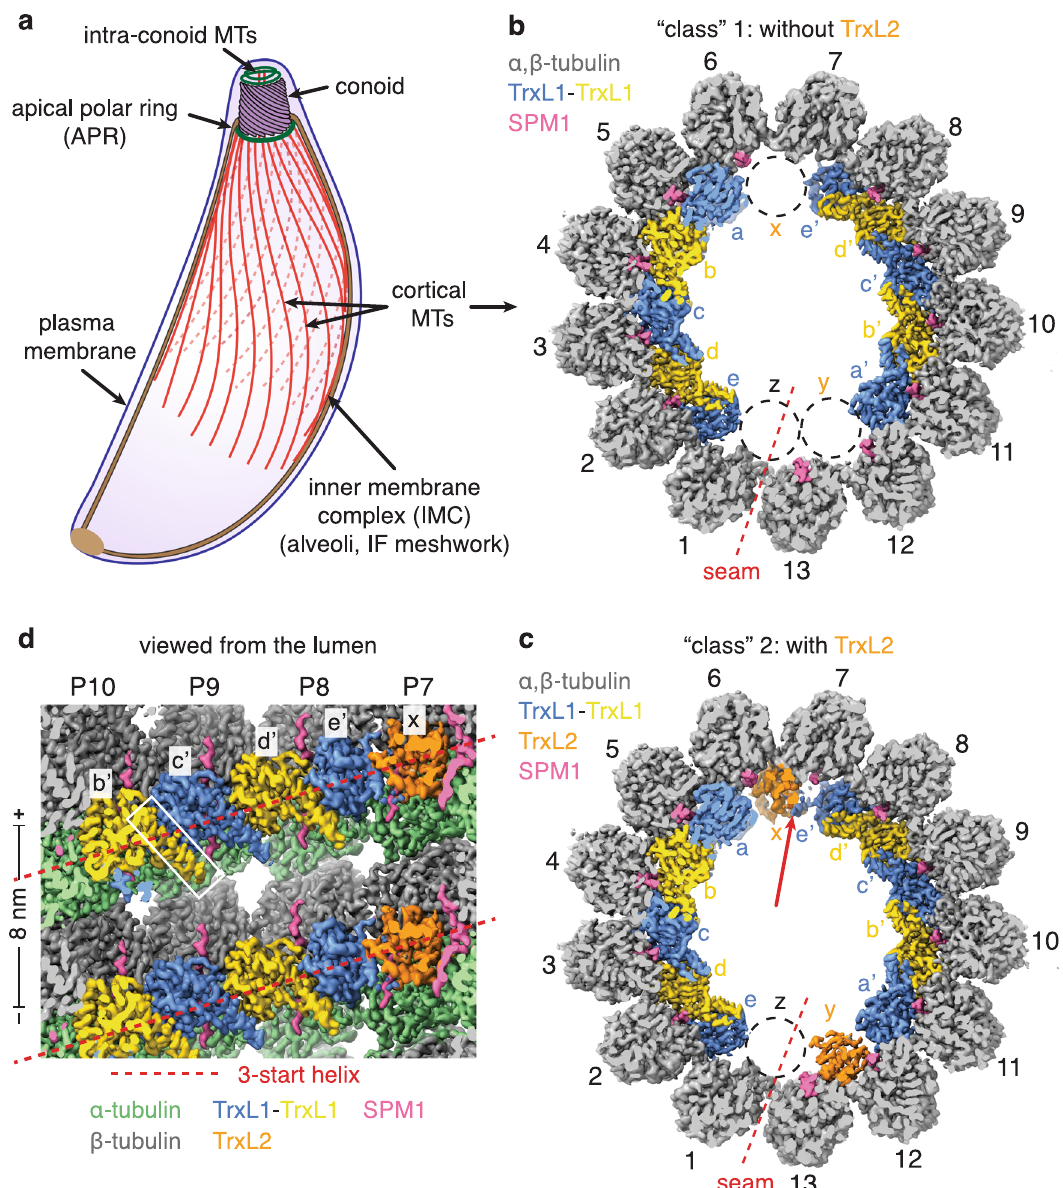
Fig. 1 Overview of the cryo-EM structures of cortical MT from T. gondii . a Cartoon diagram of T. gondii showing plasma membrane, inner membrane complex (IMC) (including the alveoli and an intermediate fi lament (IF)-like protein meshwork), the apical complex (a conoid and two intra-conoid MTs), the apical polar ring (APR) and 22 cortical MTs. b – c Cross section view of the cryo-EM structure of T. gondii cortical MT with ( b ) and without ( c ) TrxL2 at sites x and y. The structures show an asymmetric arrangement of the microtubule inner proteins (MIPs) including TrxL1 (gold or blue), TrxL2 (orange), and SPM1 (pink). An unoccupied site at the MT seam is labeled as z. Composite DeepEMhancer-sharpened maps (see “ Methods ” ) are used for visualization. The quotation marks on “ class ” 1 and “ class ” 2 indicate that the two composite maps only differ in sub-regions containing sites x and y. d The same as ( c ), but showing the luminal surface of the tubulin and MIPs. The N-terminal helix of TrxL1 (marked by white rectangle) inserts into a binding pocket of the neighboring TrxL1 molecule. The helical paths for the 3-start helix of the MT are indicated by dashed red